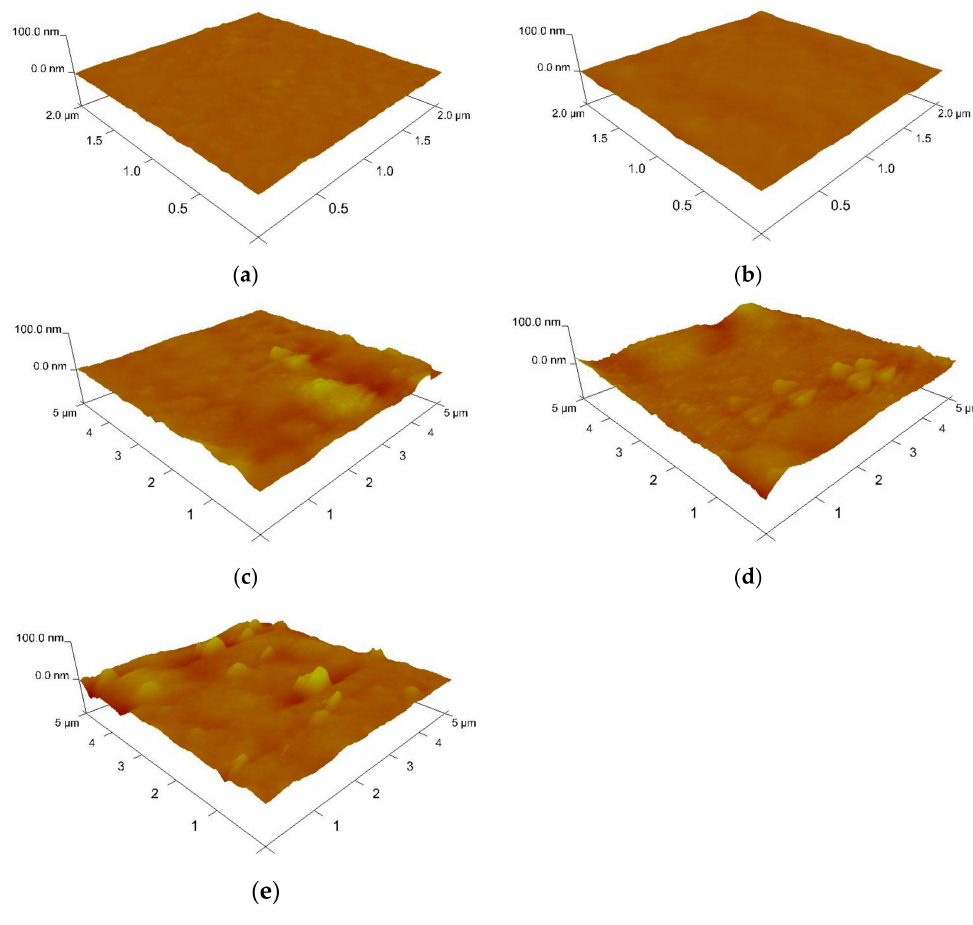
Figure 3. Three-dimensional (3D) atomic force microscopy (AFM) images of ( a ) the MEH–PPV/PFO hybrid, ( b ) the CsPbBr 3 -PQDs, and ( c – e ) the PQDs/(MEH–PPV/PFO) composite films containing PQDs weight ratios of 1 wt.%, 5 wt.%, and 10